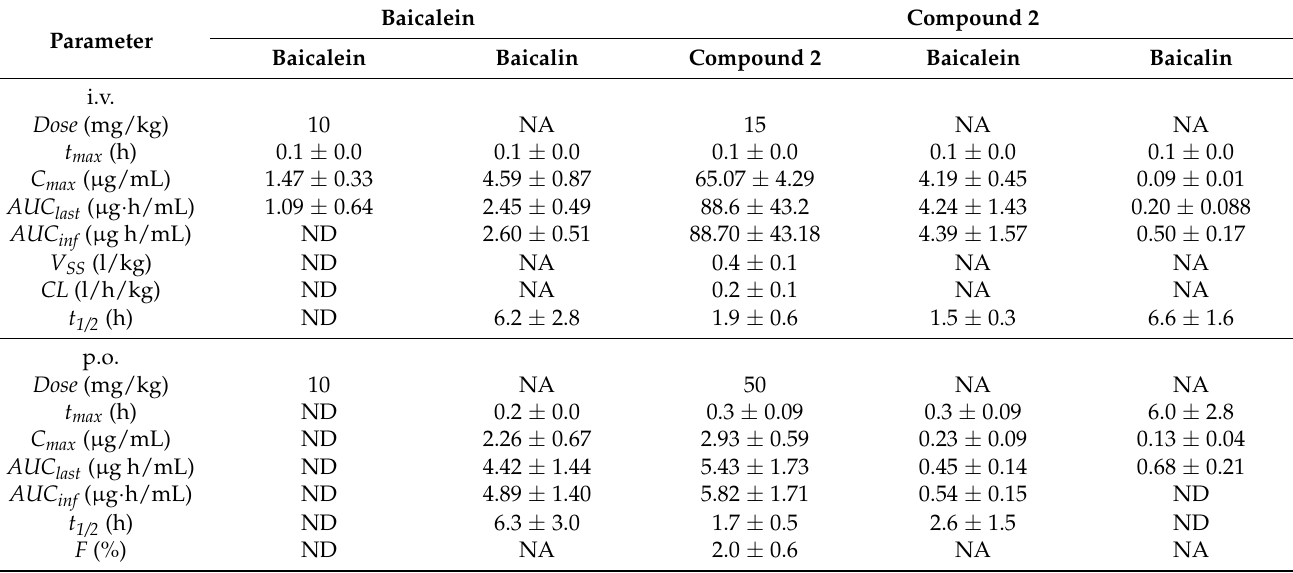
Table 3. Pharmacokinetics of baicalein and compound 2 in